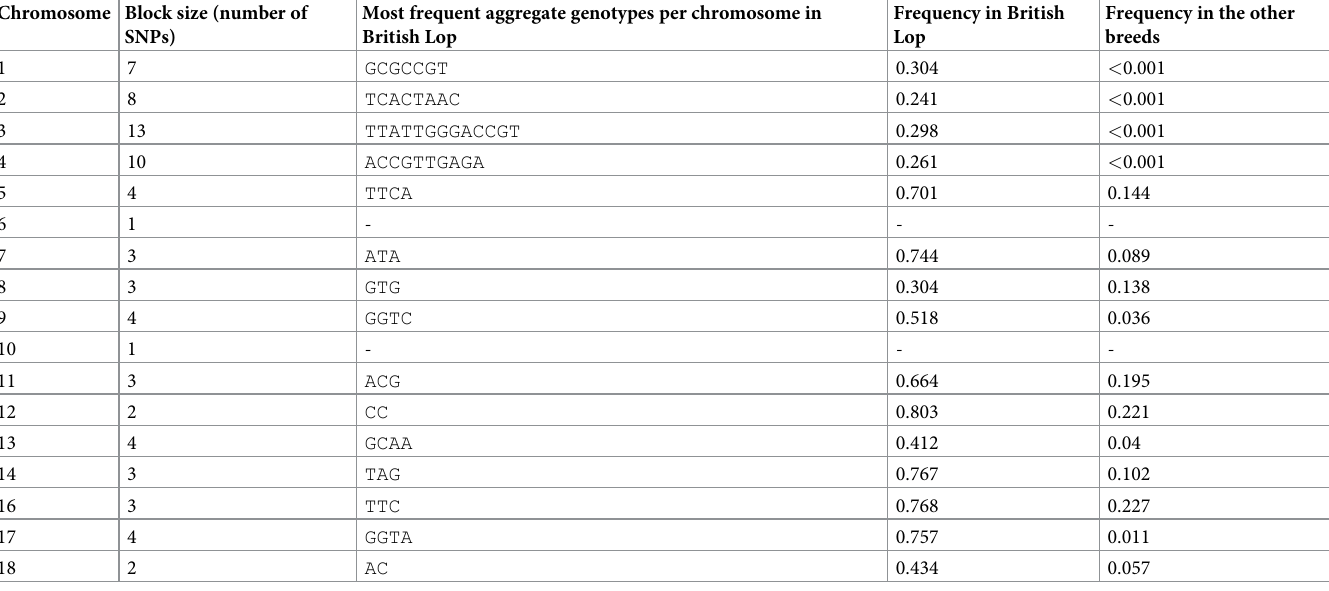
Allele coding is according to the Illumina Forward strand calling system from the 10.2 genome